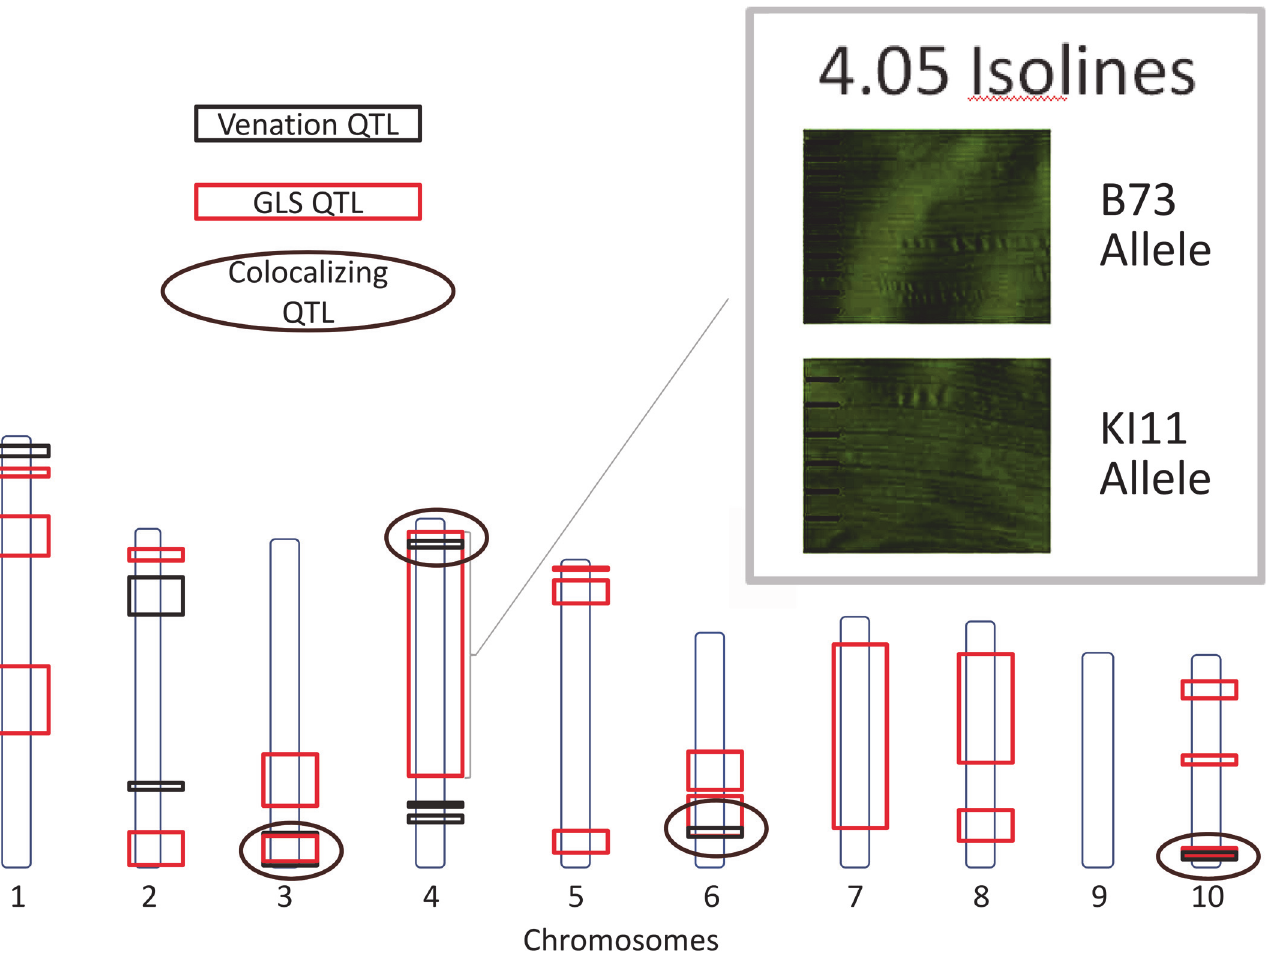
Fig 6. Gray leaf spot (GLS) and venation quantitative trait loci. Quantitative trait loci for GLS and inter-vein distance (IVD) are indicated. Circles designate co-localizing areas. Scanned leaf images (upper-right corner) demonstrate the difference between IVD from maize leaves with B73 and KI11 alleles at qGLS4.05